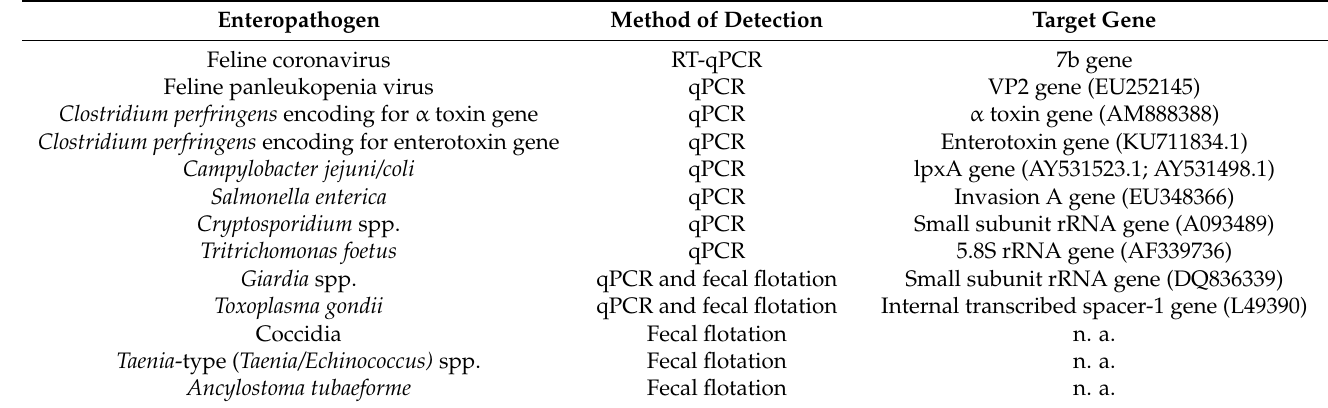
Figure 1. Interpretation of results of the reverse transcriptase quantitative polymerase chain reaction (RT-qPCR) for feline coronavirus (FCoV) RNA. Ct = threshold cycle; 1 Low concentration of FCoV RNA detected. Table 2. Method of detection and target genes for detection of potential enteropathogens using reaction (RT-qPCR) and fecal